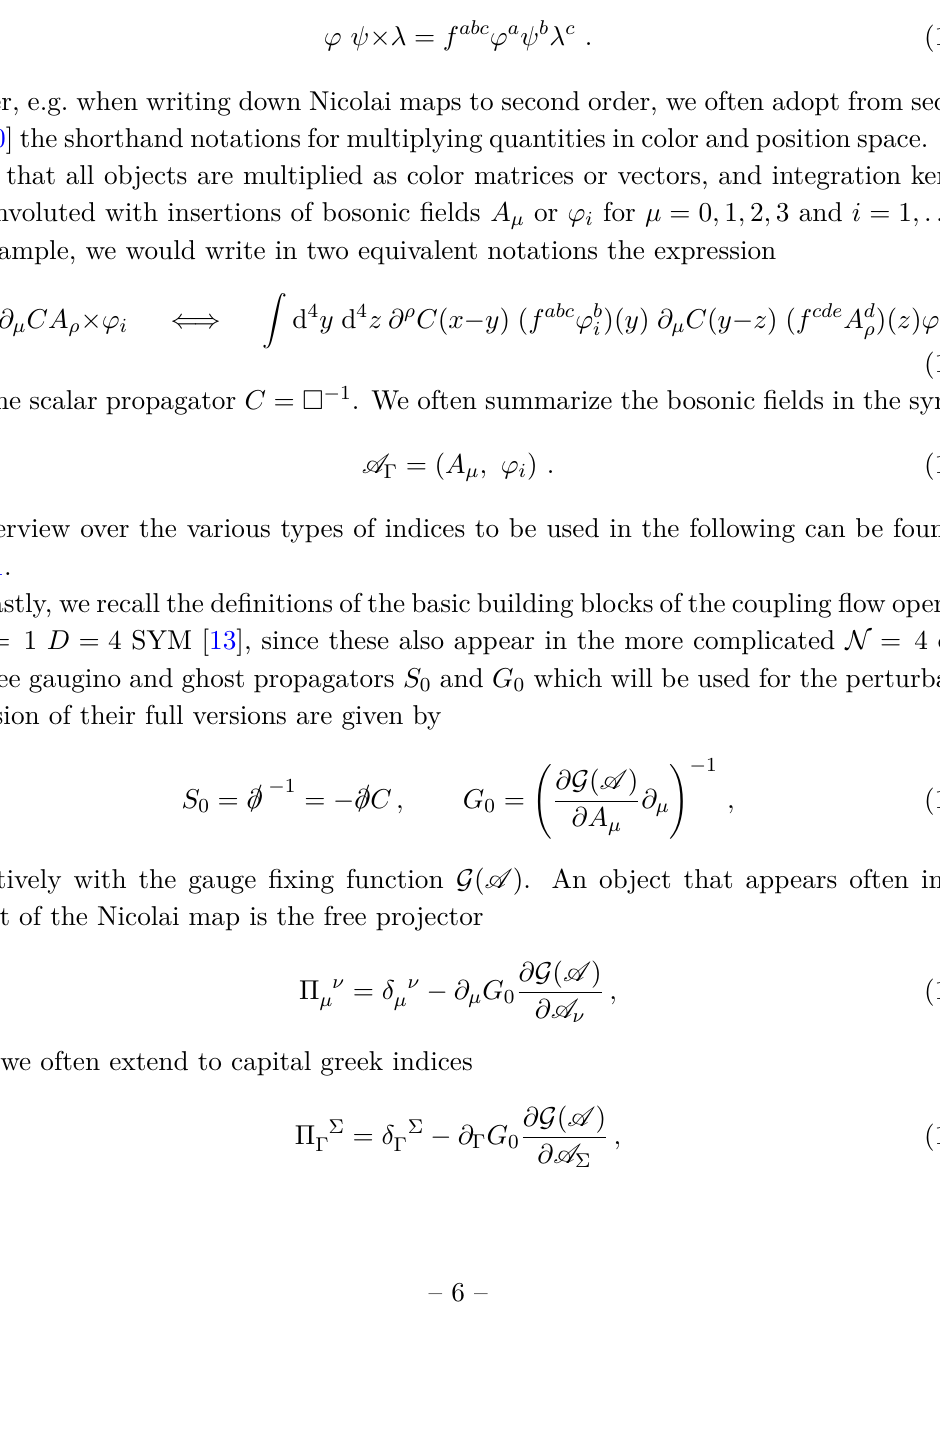
Table 1 . Types of indices used in this paper. Color and spinor indices are often left implicit. except when we write an explicit cross product,